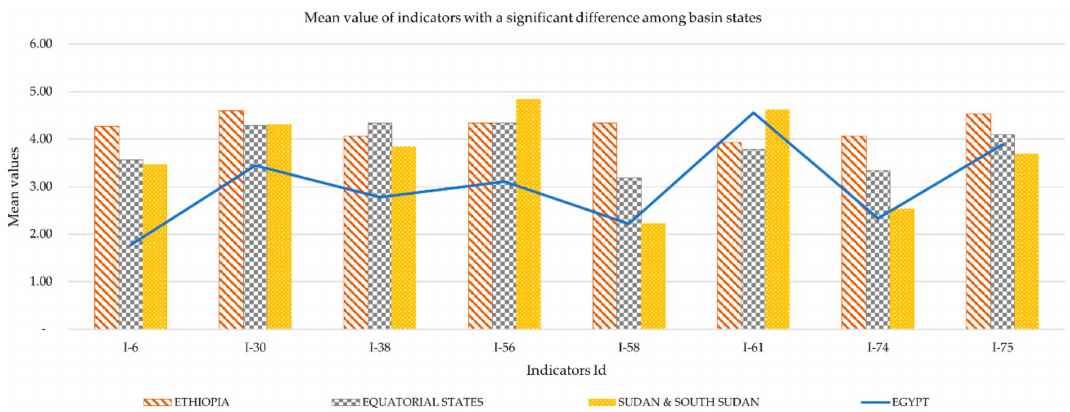
Figure A3. Mean value of indicators for which basin states were statistically significantly di ff erent.